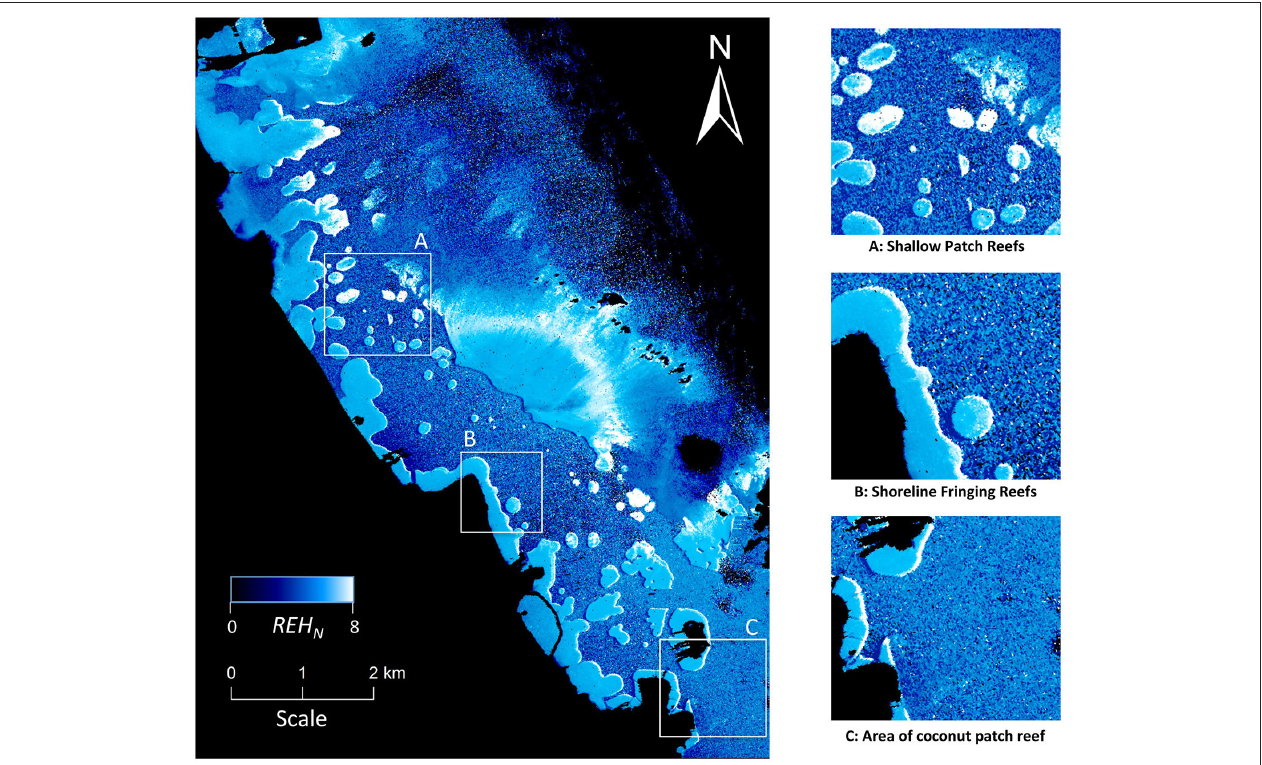
FIGURE 15 | REH N derived from AVIRIS imagery of Kane’ohe Bay collected on 3 March 2017. Land, clouds, and values of REH N < 0 are displayed as black. (A) Shallow patch reefs in the northern bay yielded some of the largest signals. (B) Narrow fringing reefs along the coastline are well resolved. (C) REH N from the area of the coconut patch reef, where D > 3m, was not significantly different than the surrounding deep